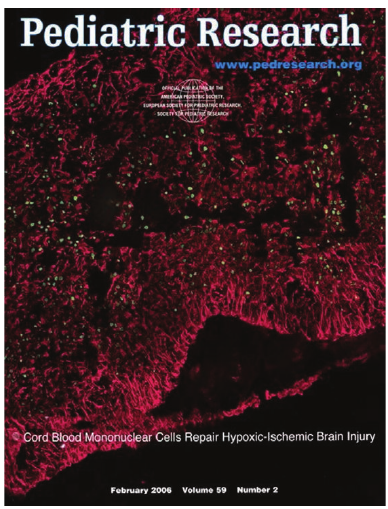
Figure 1: Intraperitoneal transplantation of mononuclear hUCB- derived cells resulted in a specific “homing” of these cells into the CNS and incorporation around the lesioned area. Title page from [17, Figure 3(B)]. HLA-DR-positive mononuclear cells ( green ) are located within a scaffold of GFAP-positive astrocytes ( red ) in the area of the hypoxic-ischemic lesion. This paper is available online at: